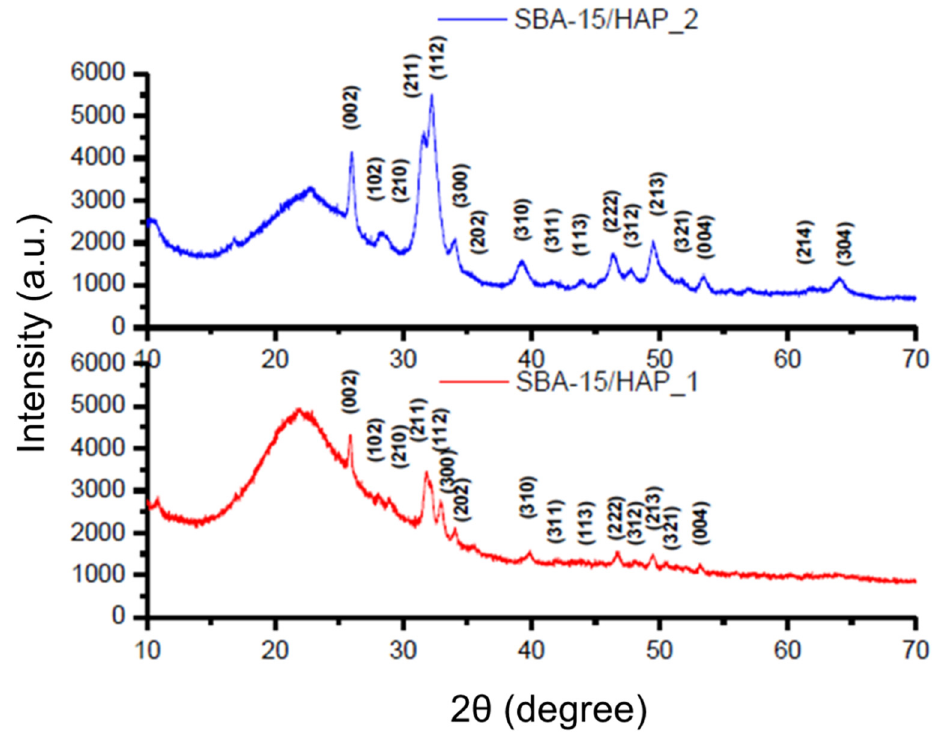
Figure 7. Wide-Angle X-Ray Diffraction patterns of SBA-15/HAP_1 and